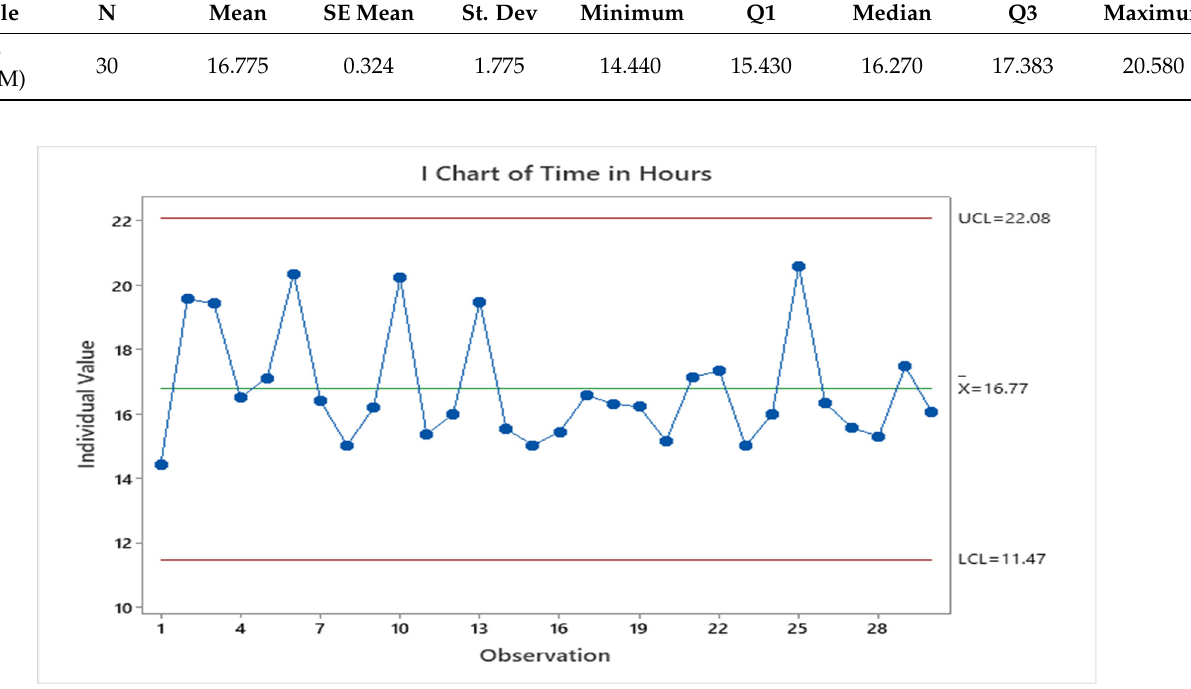
Figure 7. Time from OPD appointment to the scheduling of surgery.